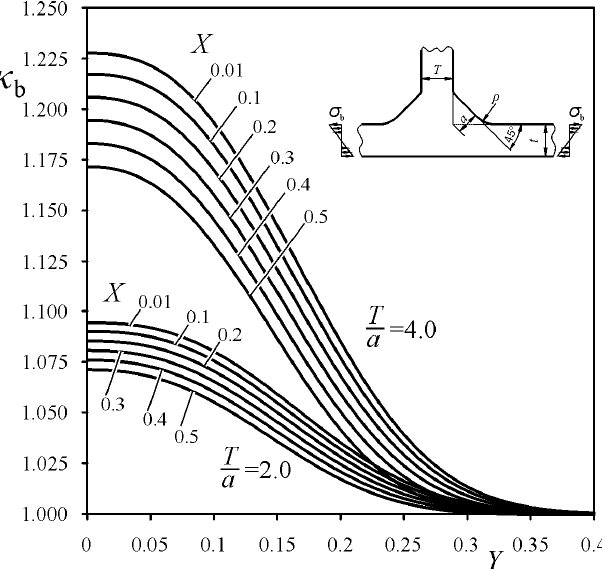
t for tensile load, while θ = 45